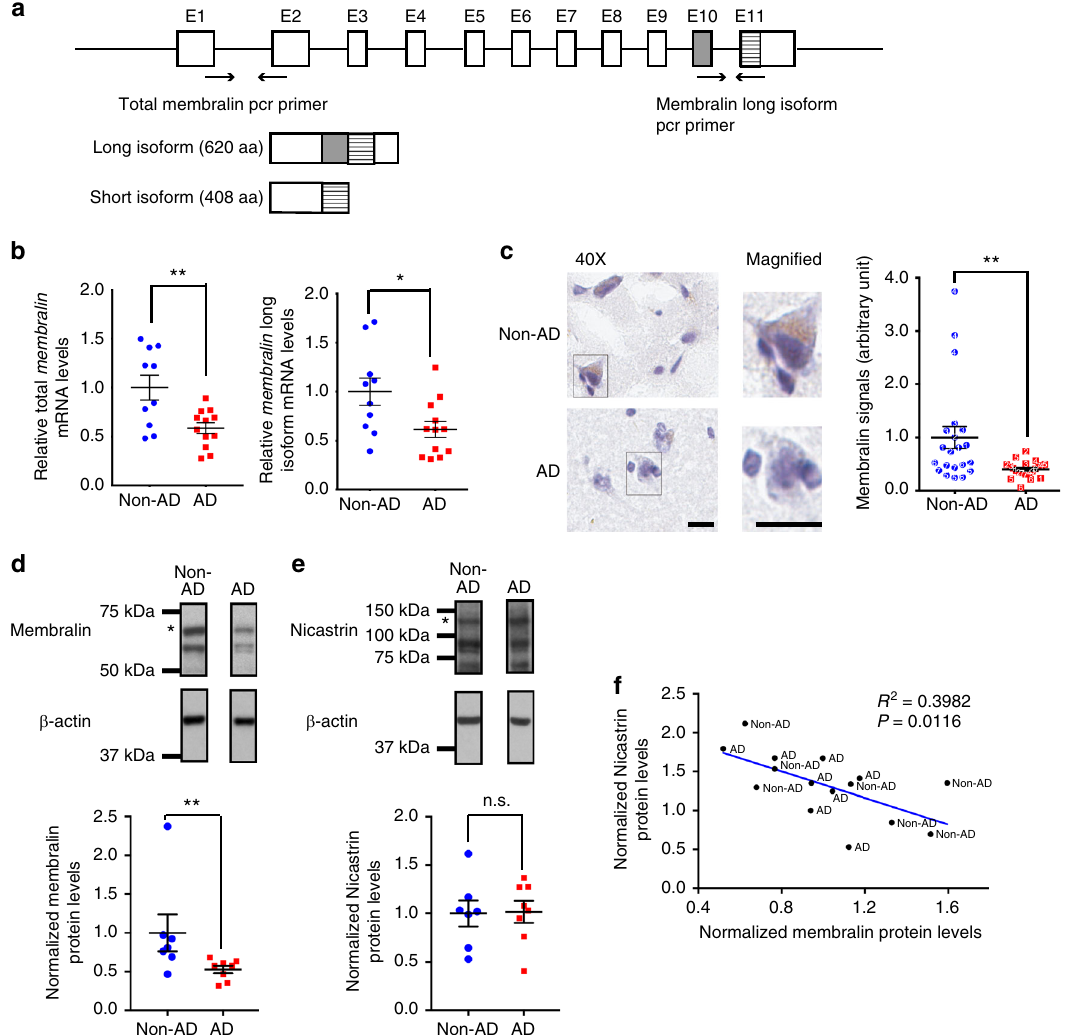
Fig. 5 Membralin expression levels are dysregulated in AD brain. a Intron/exon distribution of human membralin long and short isoforms (top), and schematic depiction of membralin long (620aa) and short (408aa) protein isoforms (bottom). Primers used to detect total and membralin long isoforms were shown. b Quanti fi cation of total and long membralin transcripts in non-AD and AD brain normalized to the 18 s ribosomal RNA control ( n = 10 for non- AD samples; n = 12 for AD samples). Data represent mean ± s.e.m. unpaired t -test, * P < 0.05, ** P < 0.01. c Membralin expression detected by immunohistochemistry staining ( brown ) with hematoxylin counter-staining ( purple ) in human postmortem tissues (three random fi eld images from each sample were quanti fi ed using Leica Aperio analysis software in a blinded manner from a total of n = 7 samples per group). Data generated from individual samples are indicated with a sample ID. Scale bars, 15 μ m. Data represent mean ± s.e.m. unpaired t -test, ** P < 0.01. d , e Western blot analysis and quanti fi cation of d membralin and e nicastrin protein levels in non-AD ( n = 7) and AD ( n = 8) samples. Representative images from the same blots are shown. Asterisks indicate membralin d and nicastrin e . Data represent mean ± s.e.m. unpaired t -test, ** P < 0.01, n.s. no signi fi cance. f Correlation analysis of membralin ( X axis) with nicastrin protein levels ( Y axis) in non-AD and AD samples. Y = -0.3401 * X + 0.8727, R 2 = 0.3982, P = 0.0116 ( n = 7 for non- AD samples, n = 8 for AD samples); the slope was found to be signi fi cantly deviant from non-zero by linear regression